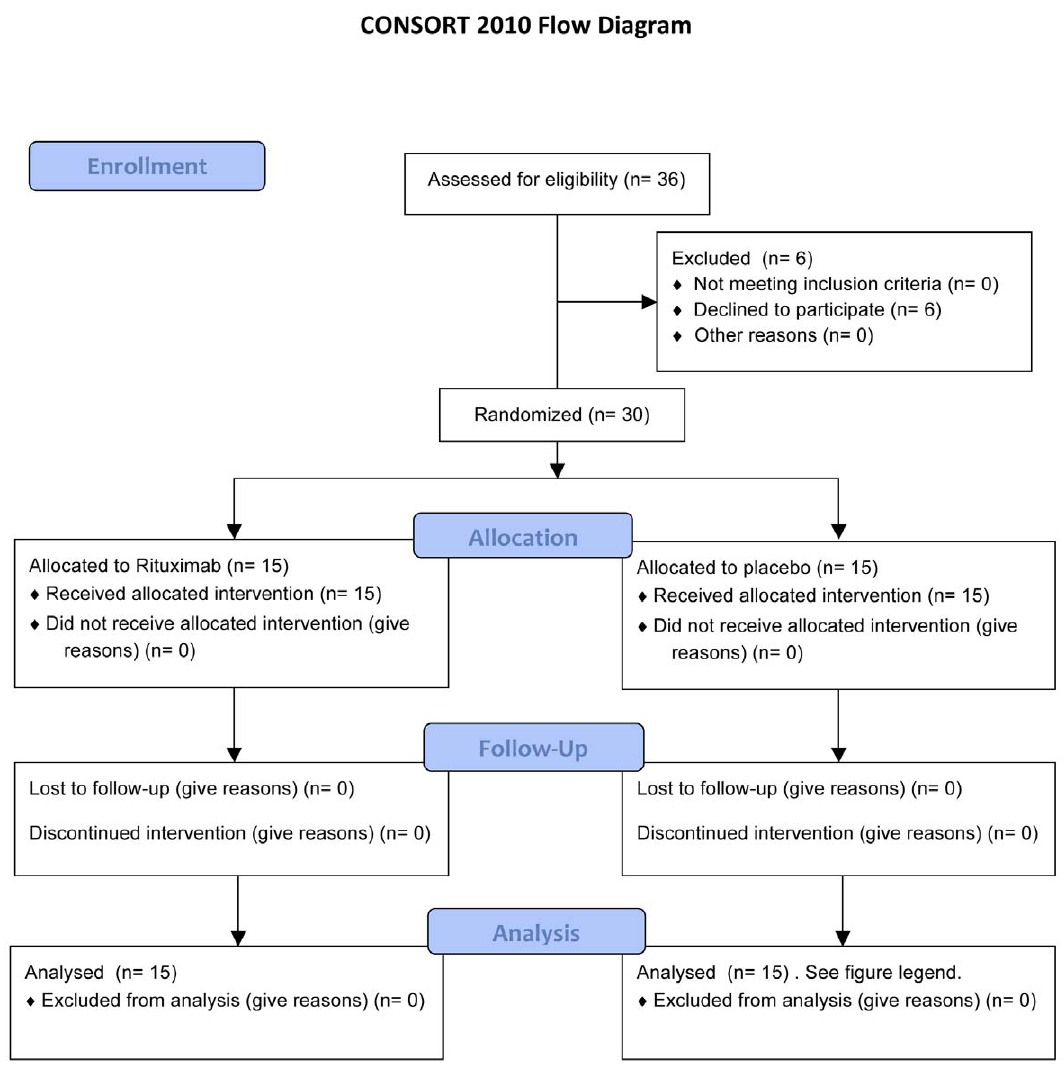
Figure 1. Study flow-diagram. Approximately 60 patients with CFS diagnosed by a neurologist were identified from the hospital files and contacted by telephone for an interview, and 36 of these were invited for a further thorough assessment. During 12 months follow-up, one out of 15 patients in the placebo group was excluded from further analysis after 28 weeks due to pregnancy, and one after 42 weeks due to study withdrawal and patient’s decision to start alternative